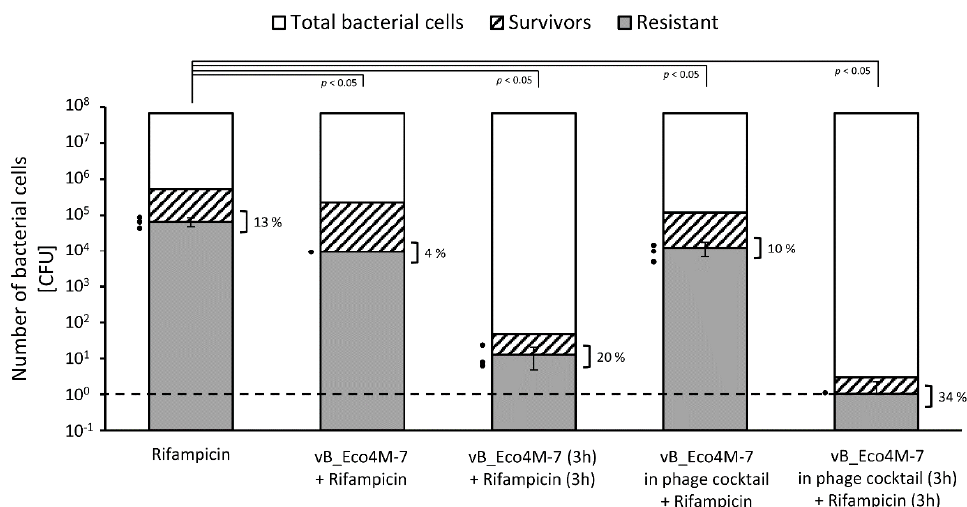
Figure 4. Number of surviving cells (columns with black stripes) and rifampicin-resistant E. coli O157:H7 (ST2-862) mutants (gray columns) among survivors after biofilm treatment for 6 h with different antimicrobial agents, individually or in the following combinations: rifampicin (400 × MIC), vB_Eco4M-7 phage (MOI of 100) mixed with rifampicin (400 × MIC), vB_Eco4M-7 phage (MOI of 100) replaced after a 3-h incubation with rifampicin (400 × MIC), the phage cocktail (10 10 PFU/well) mixed with rifampicin (400 × MIC), the phage cocktail (MOI of 100) replaced after a 3-h incubation with rifampicin (400 × MIC). Control represents the total number of bacterial cells (white columns) after treatment with LB medium instead of tested antimicrobial agents. Additionally, the percentage of rifampicin-resistant mutants (gray columns) among survivors (columns with black stripes) was calculated and presented next to the clamps. The black dashed line represents the lower limit of detection. Mean values from three independent experiments are shown with error bars indicating SD. The black dots next to the columns denote datapoints for rifampicin-resistant mutants from individual experiments. Statistical analyses were performed using the one-way ANOVA ( p value < 0.05 was considered statistically significant).